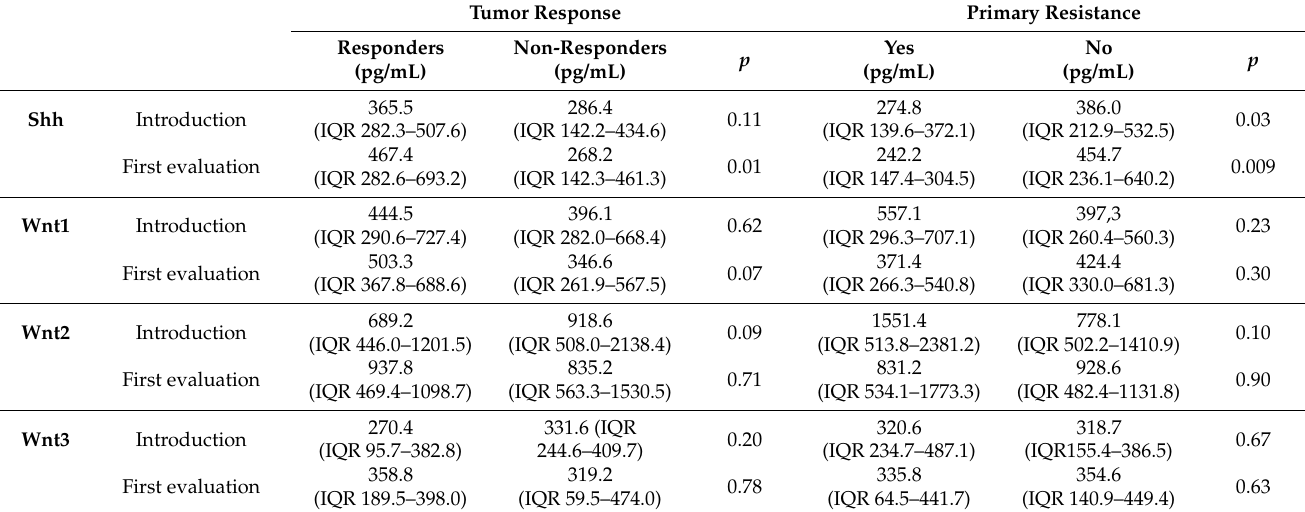
Table 2. Tumor response and primary resistance according to of Shh, Wnt1, Wnt2, Wnt3 plasma concentrations at ICI introduction and at the first tumor